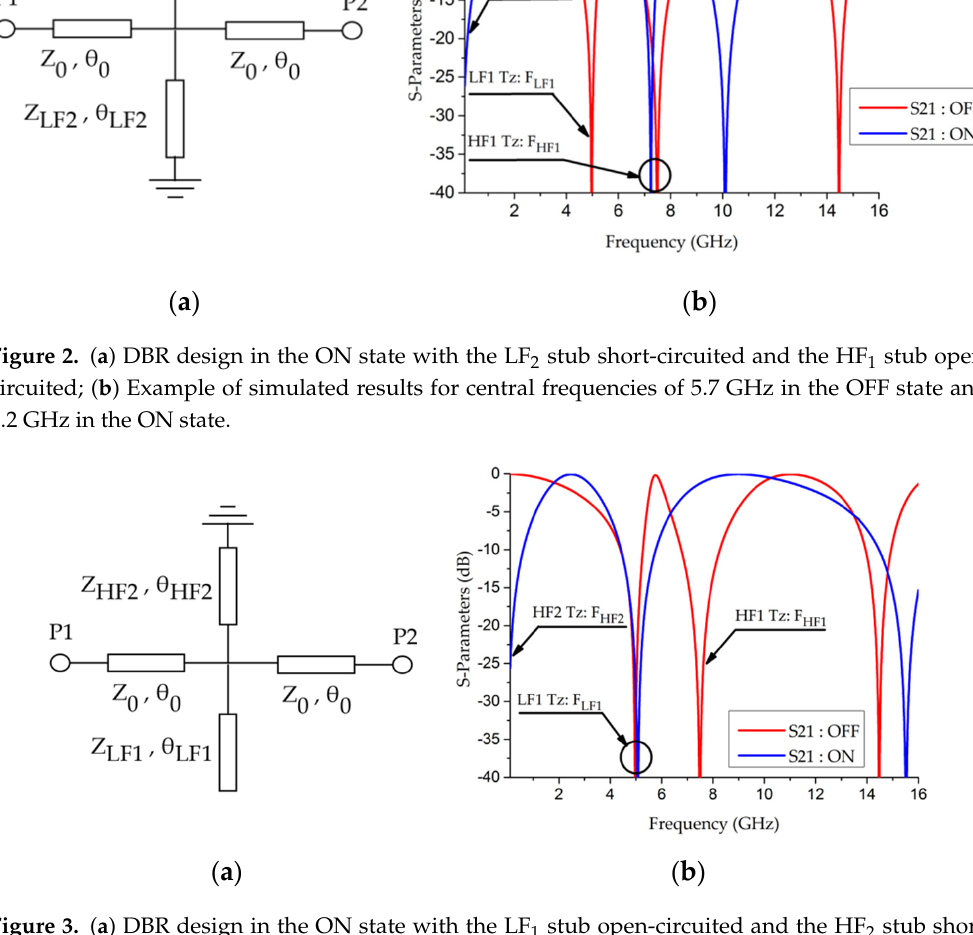
Figure 3. ( a ) DBR design in the ON state with the LF 1 stub open-circuited and the HF 2 stub short- circuited; ( b ) Example of simulated results for central frequencies of 5.7 GHz in the OFF state and 2.5 GHz in the ON state.